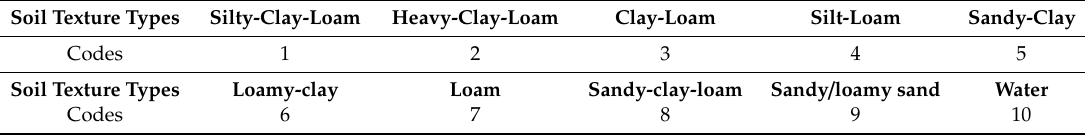
Table 3. Soil textures and codes for the infiltration